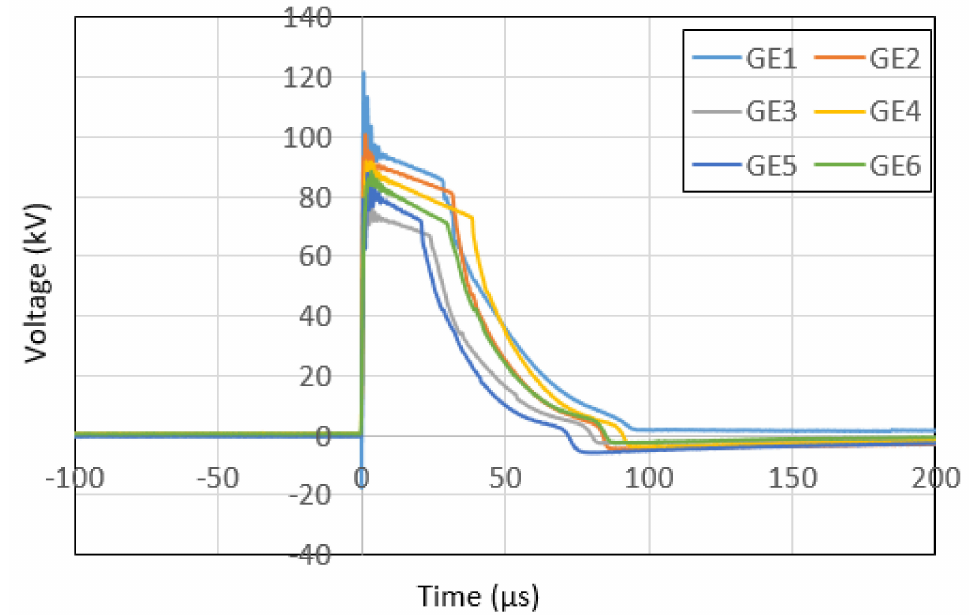
Figure 10. Voltage traces during breakdown at various applied voltages for all GEs at their breakdown voltages.